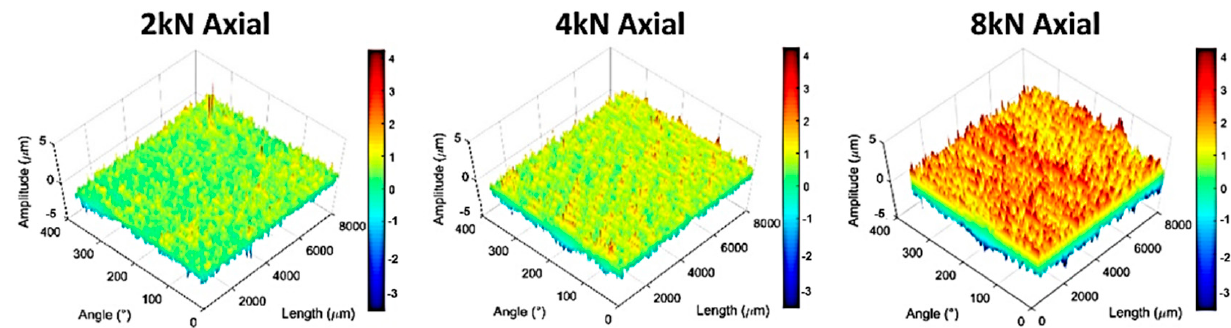
Figure 1. The distortion of microgroove amplitudes on the flattened surface of the trunnion following axial assembly forces with different magnitudes [25].